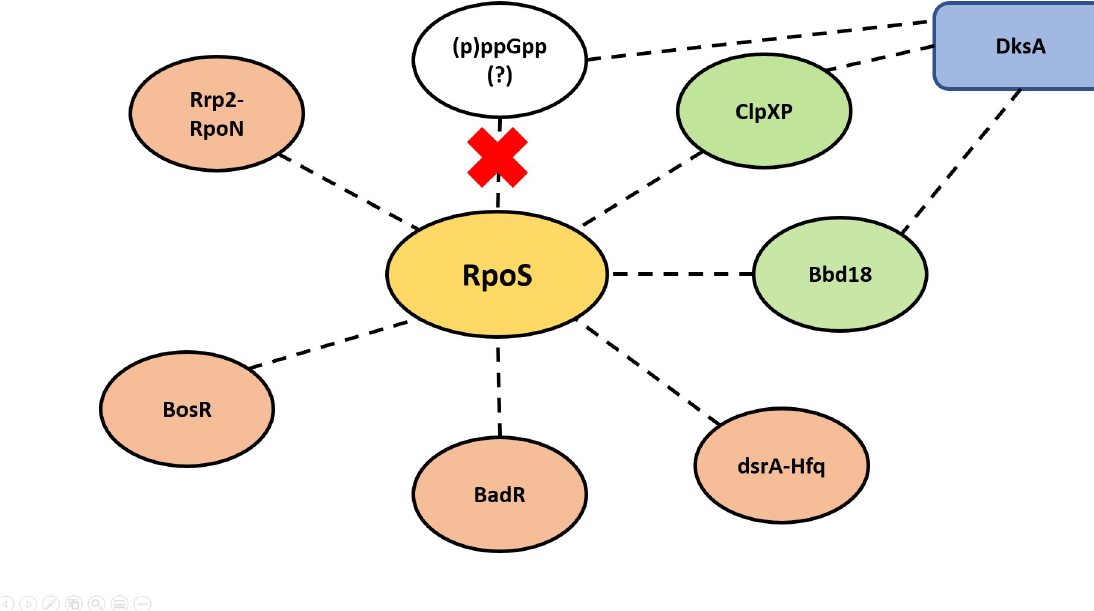
Fig 10. Transcriptional and post-transcriptional regulation of rpoS/RpoS in relation to DksA-dependent regulation. Rrp2, BosR, BadR, and dsrA -Hfq are unlikely to be contributing to RpoS regulation by DksA (indicated in red), and BBD18 and ClpXP are potential RpoS regulatory mechanisms controlled by DksA (indicated in green). In addition, there was no apparent link for the production of ppGpp to the regulation of RpoS, although DksA levels are correlated with (p)ppGpp levels.